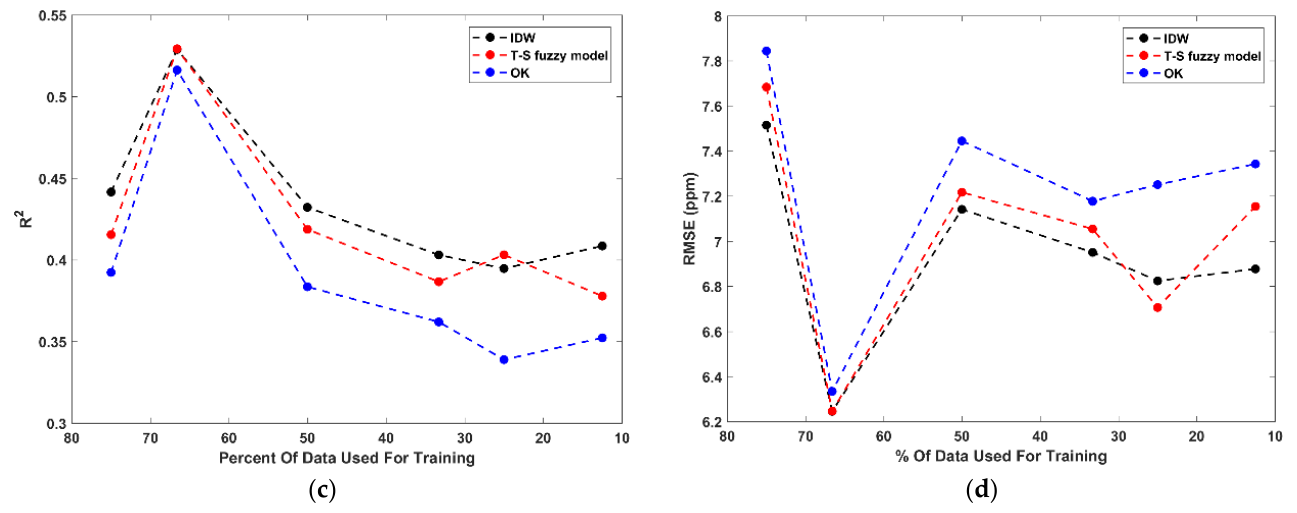
Figure 8. Ordinary kriging (OK), inverse distance weighting (IDW), and the Takagi–Sugeno (TS) fuzzy model from each increment of data reduction performance metrics ( a ) mean score, ( b ) mean absolute error (MAE), ( c ) coefficient of determination (R 2 ), and ( d ) root mean squared error (RMSE).